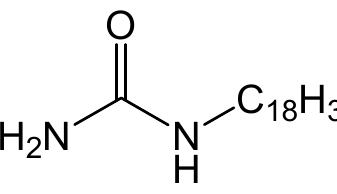
Figure 1. Molecular structure of urea organogelator.